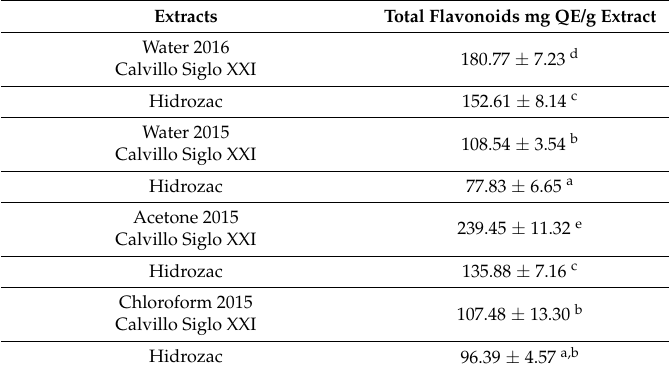
Table 2. Total flavonoids in the aqueous, acetone and chloroform leaf extracts of the varieties Calvillo Siglo XXI and Hidrozac. The average values ( ± SD) are expressed as milligrams equivalent to quercetin per gram of extract (Mg